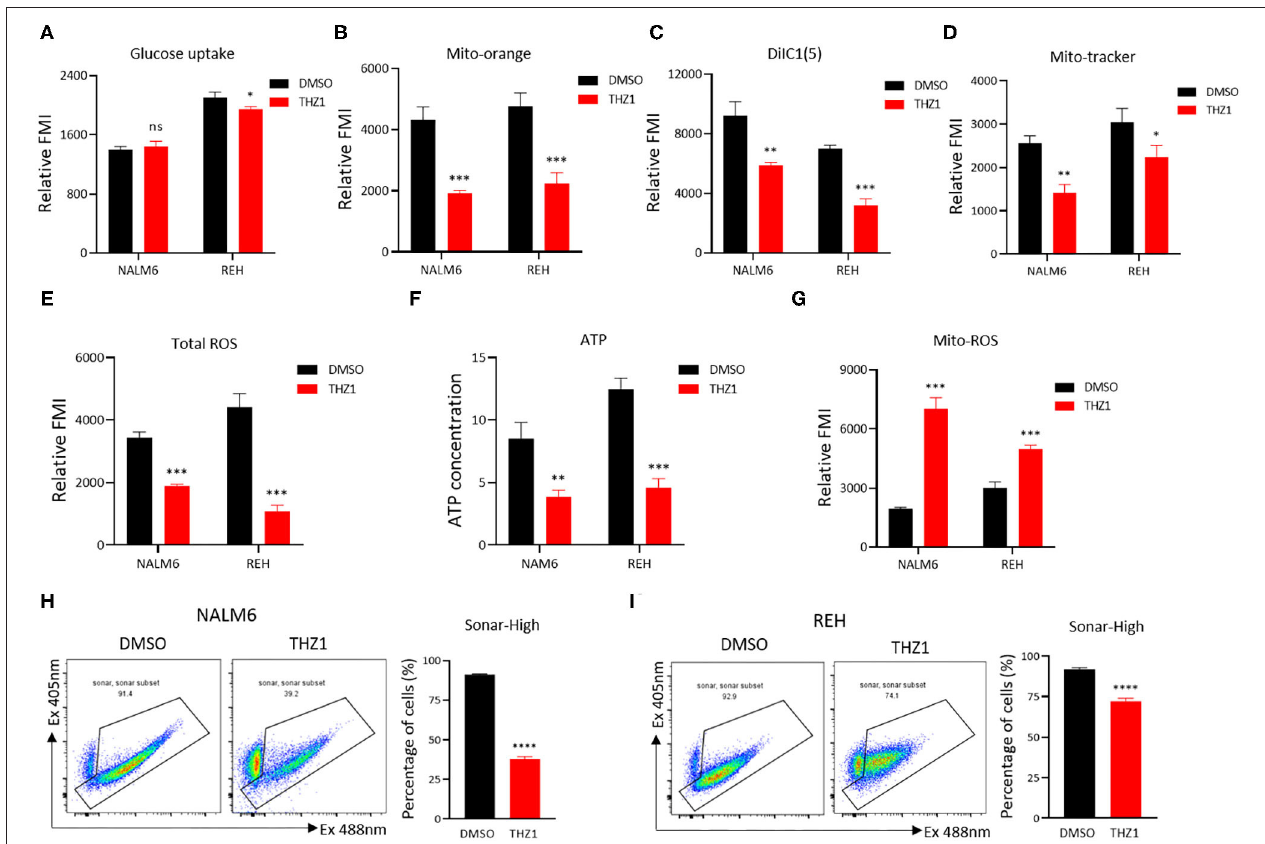
FIGURE 4 | THZ1 suppresses the cellular metabolism of B-ALL cells. (A) The glucose uptake of NALM6 and REH cells was detected by flow cytometry. (B–E) The mitochondrial membrane potential (MMP), mitochondrial mass (MM), and total ROS of B-ALL cells were detected by flow cytometry. (F) The quantification of intracellular ATP in B-ALL cells was assessed using the ATP determination kit. (G) The mitochondrial ROS (Mito-ROS) of B-ALL cells were detected by flow cytometry. (H,I) SoNar-low or -high B-ALL cells were measured by flow cytometry with 405 and 488nm excitation. B-ALL cells were treated with THZ1 for 24h. Values were shown as mean ± SEM. * p < 0.05, ** p < 0.01, *** p < 0.001, and **** p <